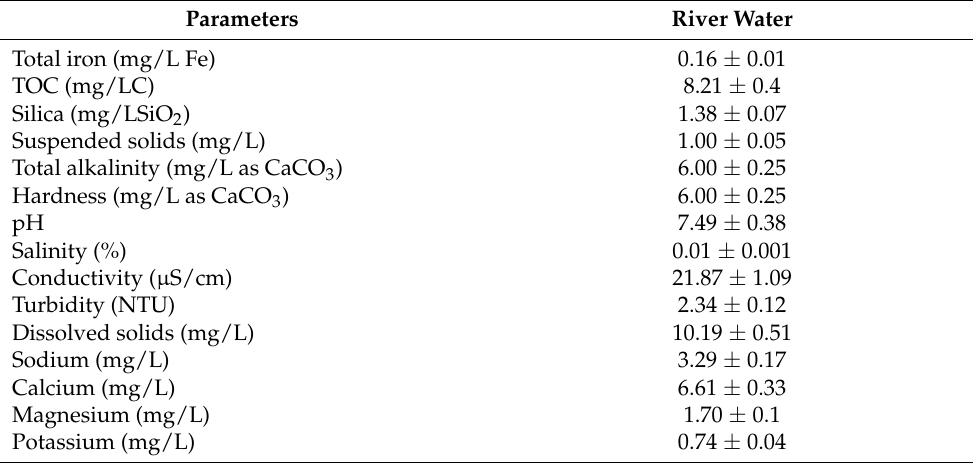
Table 1. Physiochemical characteristics of the river water.